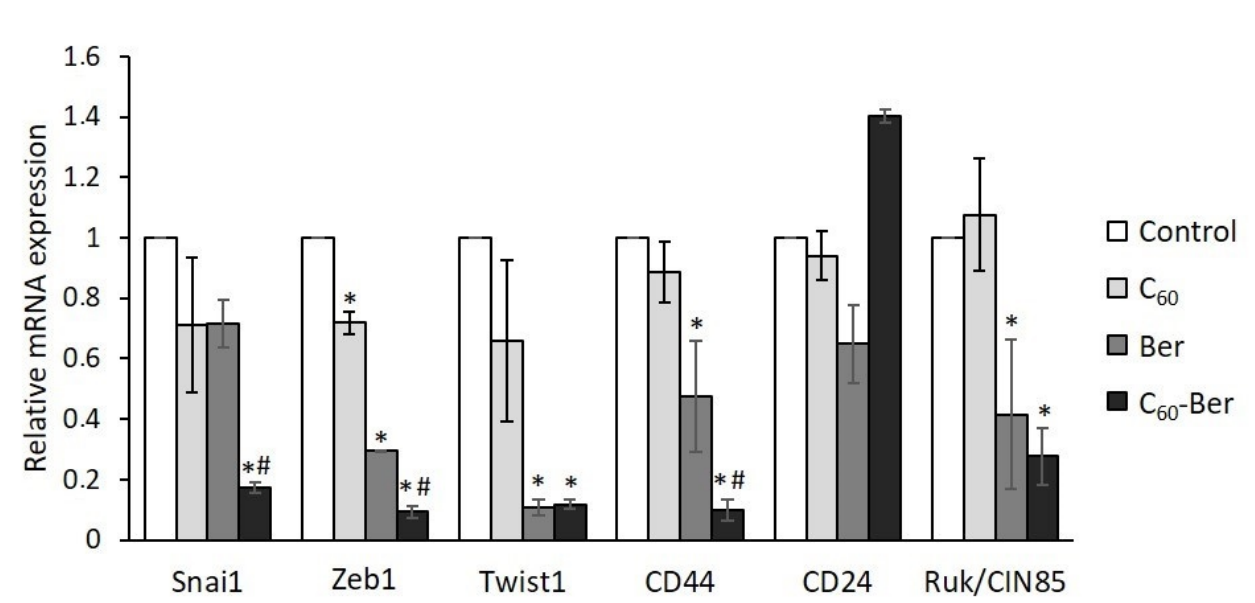
Figure 4. C 60 -Ber nanocomplex effectively attenuates the expression of EMT and CSC molecular markers in LLC cells. * p < 0.05 compared to control; # p < 0.05 compared to free Ber.